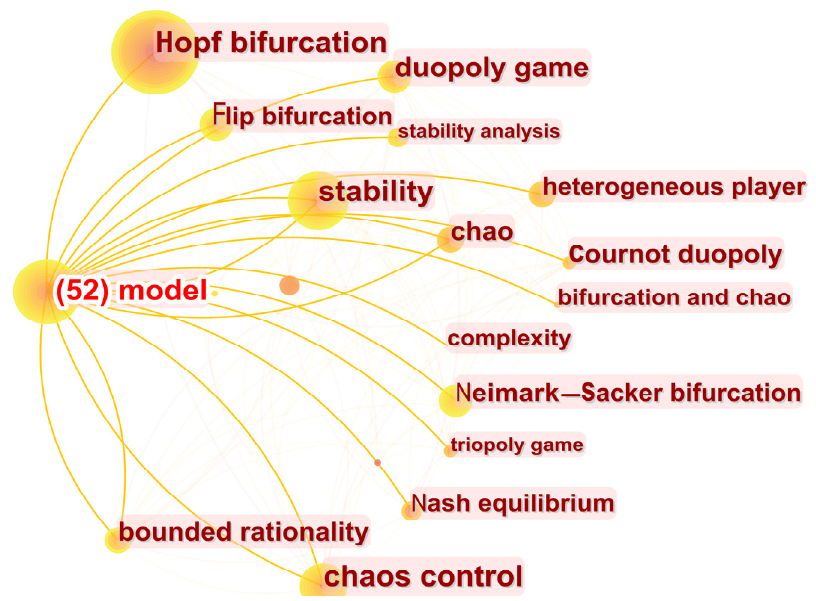
Figure 6. The co-occurrence key words of “model”.